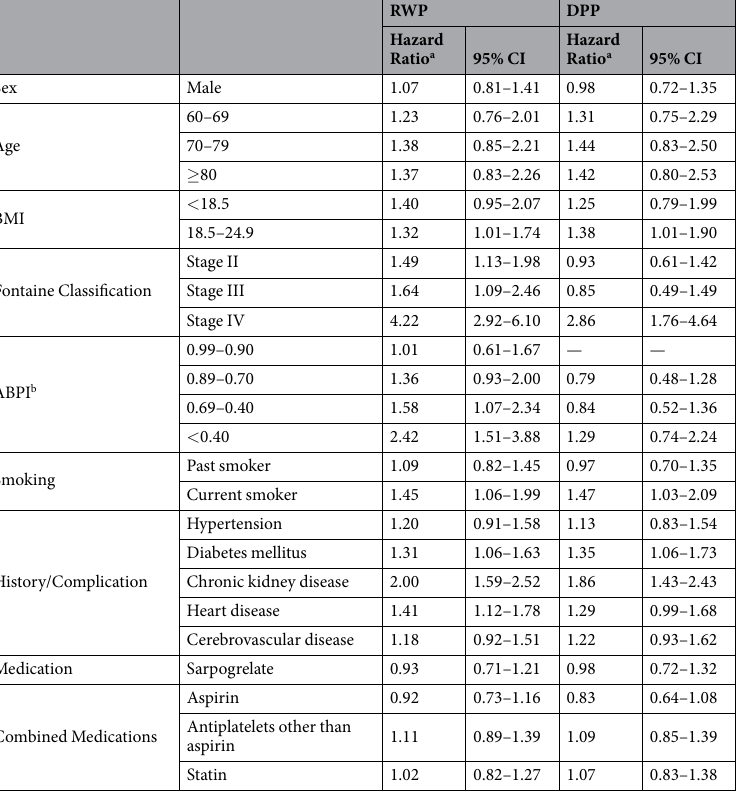
Table 3. Adjusted Hazard Ratios Based on Time to the Composite Event by Baseline Covariates and Treatment. Abbreviations: ABPI, ankle-brachial pressure index; BMI, body mass index; CI, confidence interval; DPP, definite peripheral arterial disease population; RWP, real-world population. a Hazard ratio adjusted for sex, age, BMI, Fontaine classification, ABPI, smoking, history/complication (hypertension, diabetes mellitus, chronic kidney disease, heart disease, cerebrovascular disease), medication (sarpogrelate), combined medications (aspirin agents, other antiplatelet agent except aspirin, statin). References for hazard ratios: sex (female), age (under 60), BMI ( ≥ 25), Fontaine classification (Stage I), ABPI ( ≥ 1.0 for RWP and ≥ 0.90 for DPP), smoking (non-smoker), history/complication (without each history/complication), medication (cilostazol, ticlopidine, prostaglandin